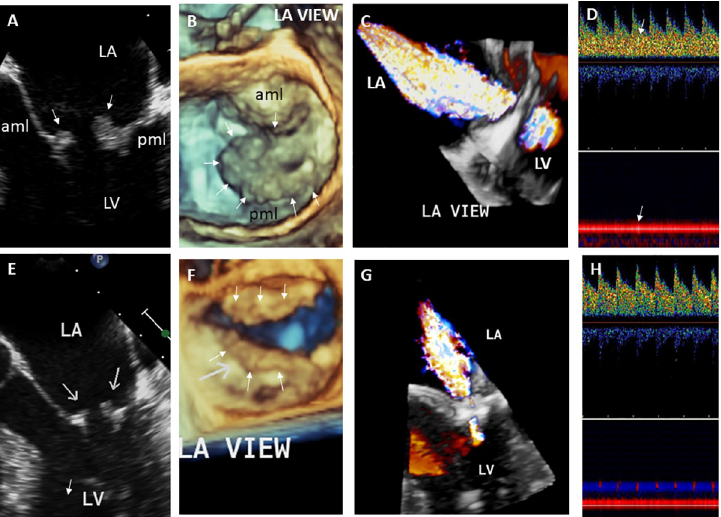
Fig 2. 29-year- old male with Libman-Sacks endocarditis complicated with acute stroke and cognitive dysfunction. A. This two-dimensional (2-D) TEE view demonstrates large (area of 1.5 cm 2 ), sessile, and oval shaped Libman-Sacks vegetations on the distal portions and atrial side of the anterior (aml) and posterior (pml) mitral leaflets (arrows). B. This 3-dimensional (3-D) TEE let atrial (LA) view of the mitral valve demonstrates large (area of 3.20 cm 2 ) and protruding vegetations on the tip to mid portions and atrial side of the entire anterior and posterior mitral leaflets (arrows). C . Associated severe mitral regurgitation is demonstrated by 3D-TEE color Doppler. D . Transcranial Doppler of the middle cerebral artery demonstrates a microembolic event within the spectral Doppler (upper arrow) and within the vessel (lower arrow). On MRI, multiple small white matter lesions totaling a lesion load of 4.3 cm 3 were demonstrated. His neurocognitive dysfunction was graded as severe. After 3 months of aspirin and clopidogrel, hydroxychloroquine, prednisone, and mycophenolate mofetil, mitral valve vegetations significantly decreased in size (arrows) by 2D ( E ) and 3D TEE ( F ) to vegetation areas of 0.22 cm 2 and 0.79 cm 2 , respectively, and mitral valve regurgitation improved to mild ( G ). Also, cerebromicroembolism resolved ( H ), his brain lesion load decreased to 2.1 cm 3 , and his neurocognitive dysfunction improved to moderate degree. Abbreviations: LA = left atrium, LV = left ventricle, aml = anterior mitral leaflet, pml = posterior mitral